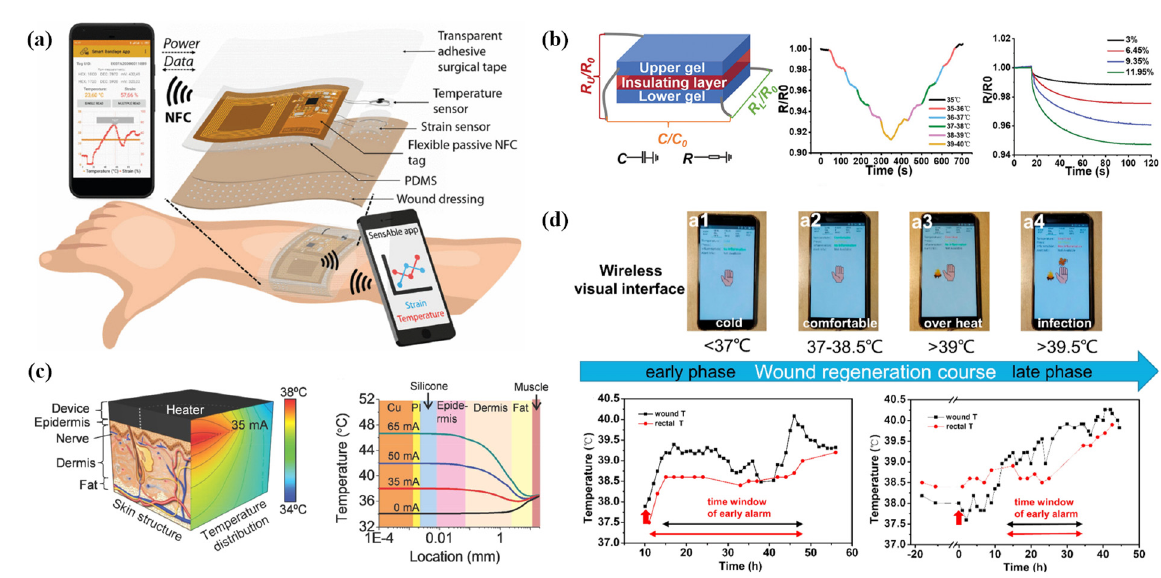
Figure 5. ( a ) Overview of the NFC-based smart bandage for wireless strain and temperature real- time monitoring [134]. Copyright (2020) IEEE. ( b ) Schematic illustration of the sandwich-structured sensor. The resistance curves with temperature change from 35 to 40 °C and back to 35 °C, and those with compressive strain change from 3% to 11.95% [135]. Copyright (2021) John Wiley and Sons. ( c ) Results of modeling the bioheat transfer equation and the calculated temperature distribution for different input currents [136]. Copyright (2014) John Wiley and Sons. ( d ) Visual indicator and alarm interface of the customized app, which would report visual wound status of corresponding wound temperature. The time–temperature curve of early-phase and late-phase infection model and rectal temperature was monitored as a control (red curve) [137]. Copyright (2020) Elsevier.